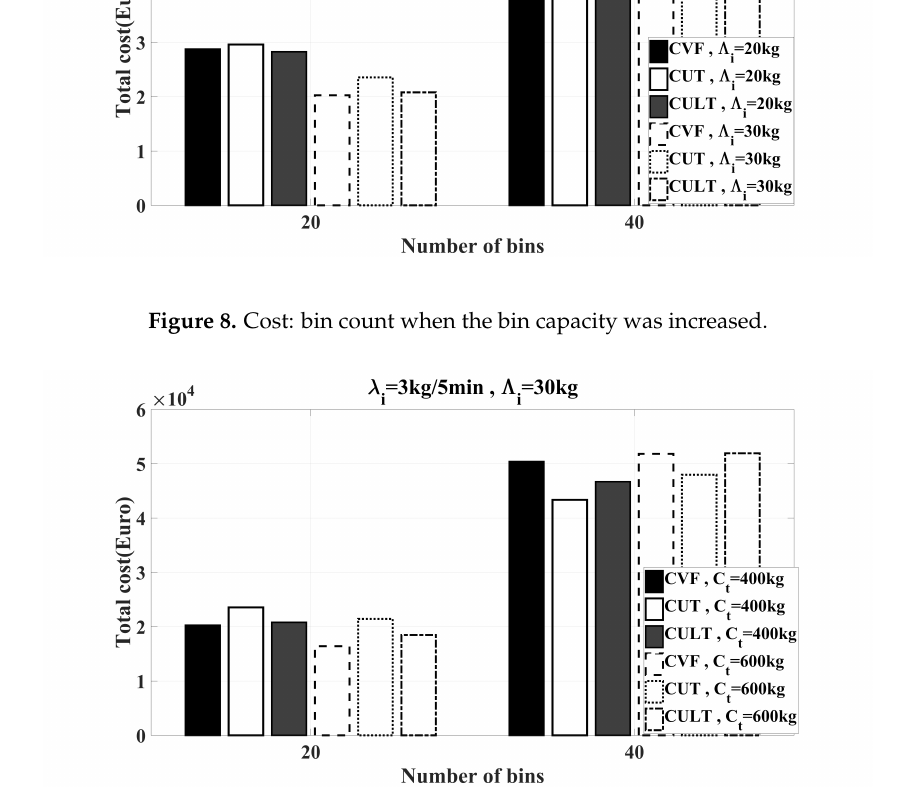
Figure 9. Cost: bin count when the truck capacity was